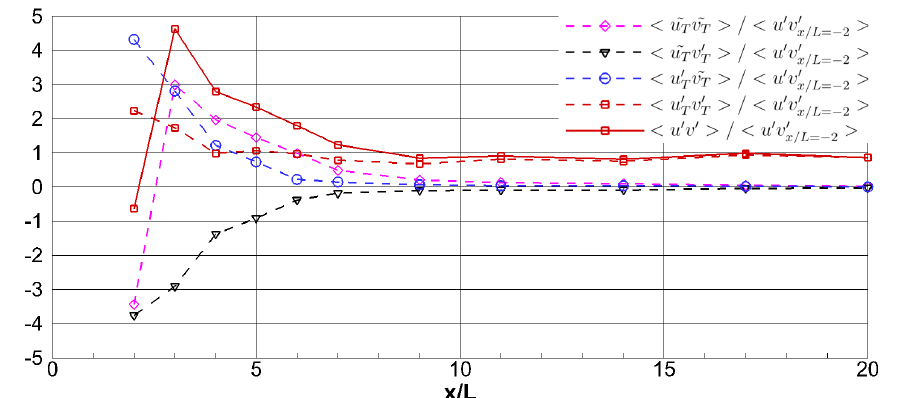
Figure 12. Normalized longitudinal distributions of the primary Reynolds shear stress near the lateral wall ( y / L = 0.05) at the turbine blade center height ( z / B = 1.5) based on the triple (dashed lines) and Reynolds decompositions (solid